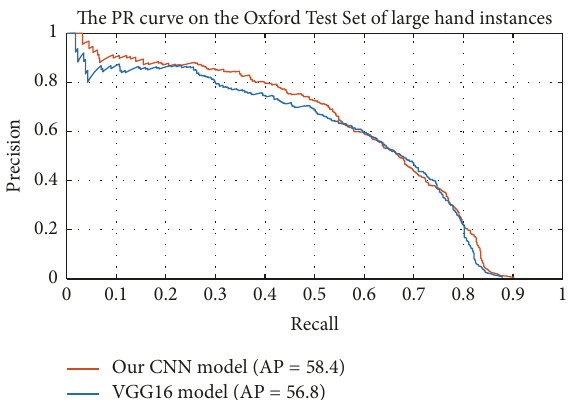
The PR curve on the Oxford Test Set of large hand instances